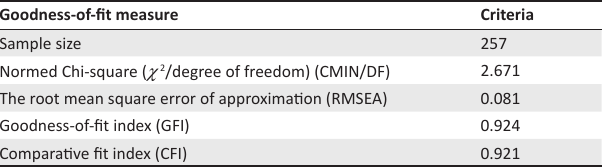
TABLE 6: Goodness-of-fit indices for the structural model leadership effectiveness.